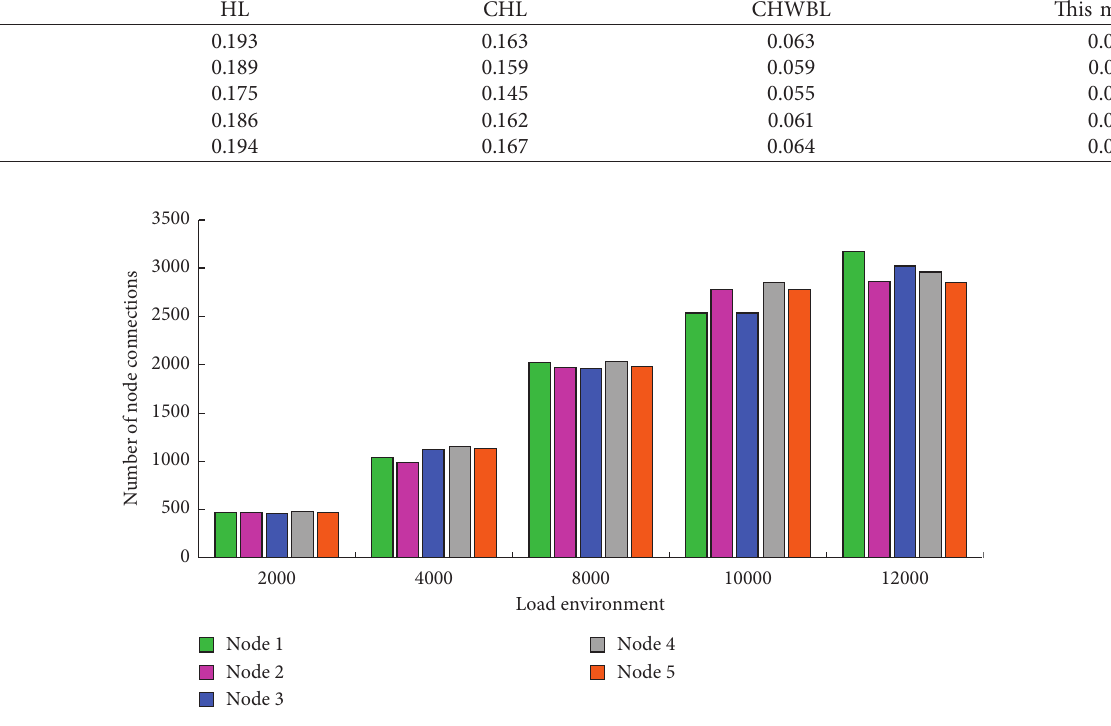
Figure 9: Distribution of node connections under different load environments.